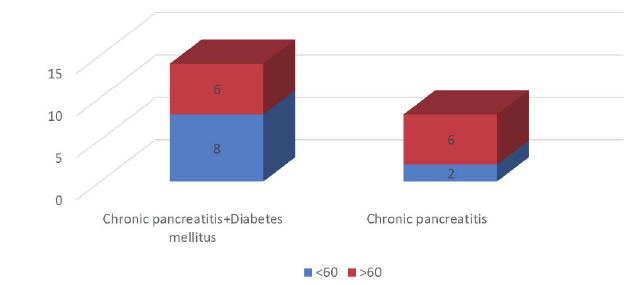
Figure 1 - The age of the patients